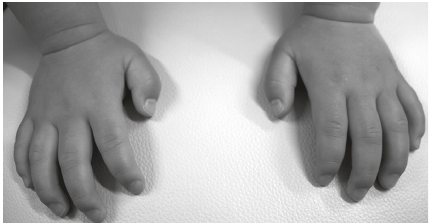
Figure 1: Hand X-ray imaging the clawhand deformity.